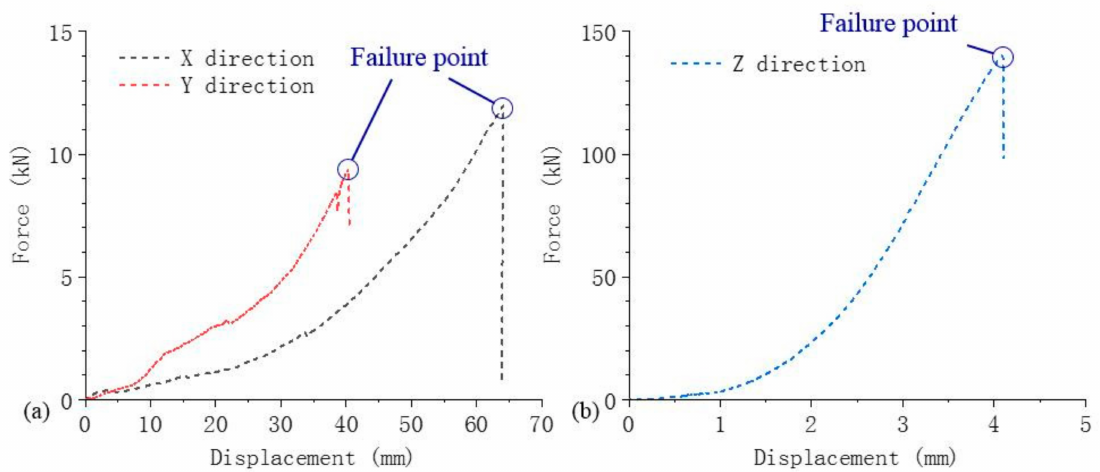
Figure 2. Test results: ( a ) X-cylindrical indentation and Y-hemispherical indentation; ( b ) Z-cylindrical